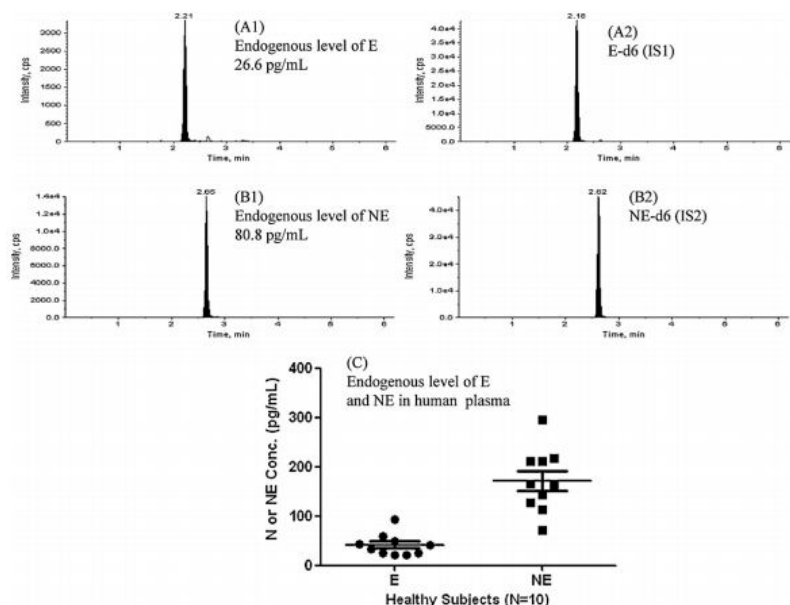
Figure 7. Representative LC-MS / MS chromatograms obtained while the monitoring of endogenous E and NE in the commercial healthy human plasma was carried out. ( A1 ) 26.6 pg / mL of basal level of E in an individual human plasma, ( A2 ) E-d6 (IS1), ( B1 ) 80.8 pg / mL of basal level of NE in an individual human plasma. ( B2 ) NE-d6 (IS2) and ( C ) the endogenous level of E and NE in 10 individual healthy human plasma samples. Figure adopted from reference [52] with the copyright permission.